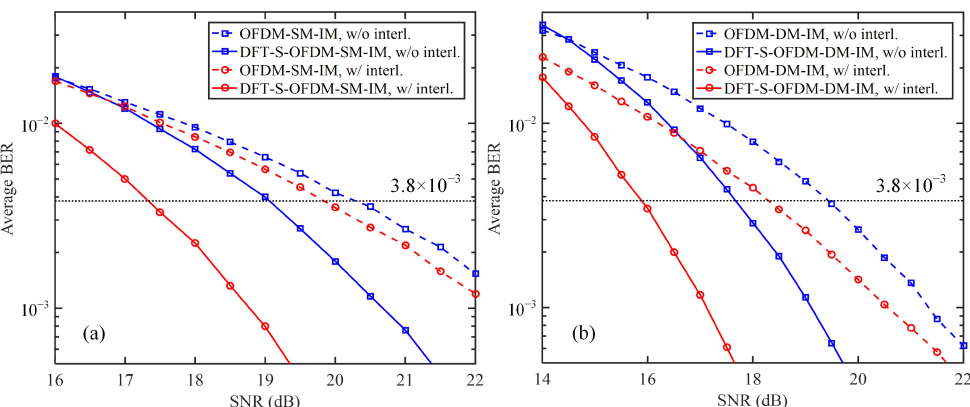
Figure 4. Simulation BER vs. SNR for ( a ) OFDM-SM-IM and DFT-S-OFDM-SM-IM and ( b ) OFDM- DM-IM and DFT-S-OFDM-DM-IM without and with interleaving over the low-pass VLC channel (w/o: without, w/: with, interl.: